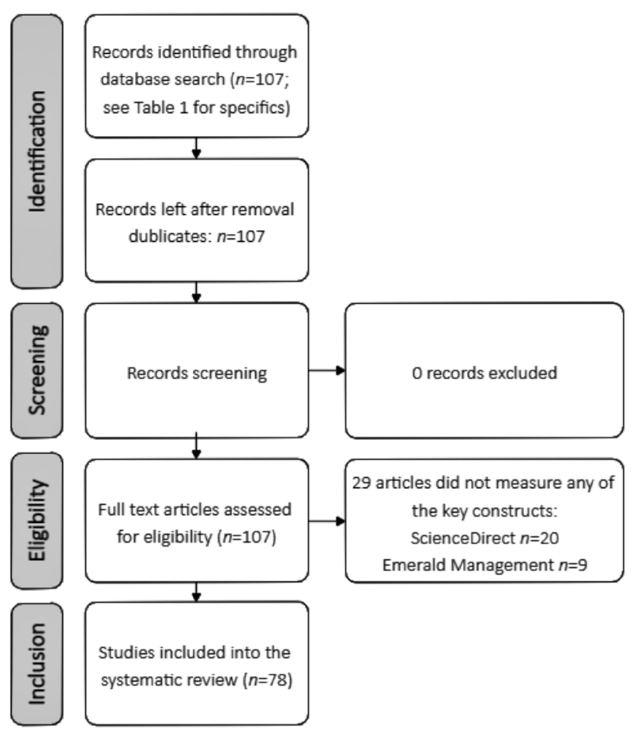
Figure 1. Article screening and inclusion procedure.